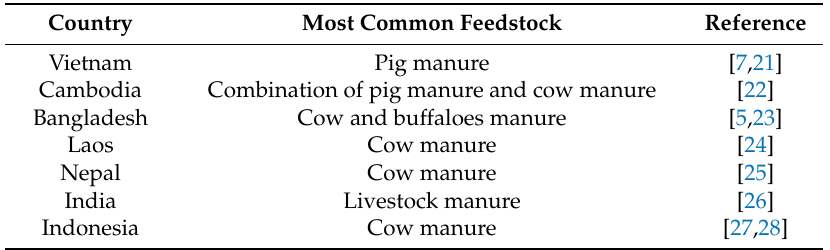
Table 1. Most common feedstock for small-scale biogas plants in selected Asian